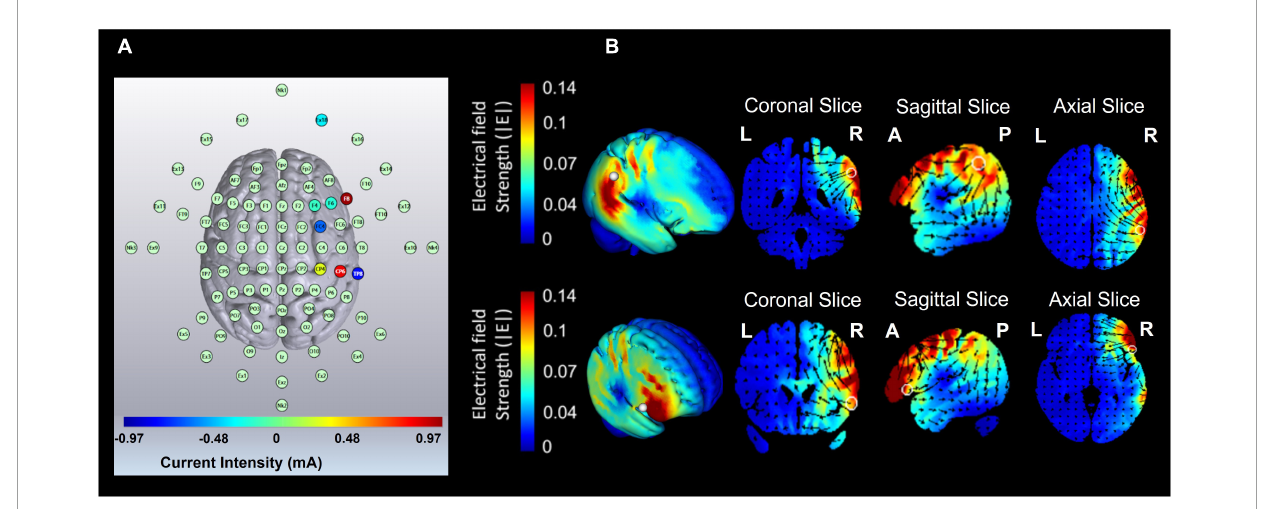
FIGURE3 Current flow modeling during 1 mA high-definition transcranial direct current stimulation (HD-tDCS) using the HD-Target software (Soterix Medical, New York, NY). (A) High-definition transcranial direct current stimulation (HD-tDCS) montage for maximal focal stimulation of the right inferior parietal lobe (IPL) and the right inferior frontal gyrus (IFG). (B) Current flow modeling during 1 mA high-definition transcranial direct current stimulation (HD-tDCS) using HD-Target software (Soterix Medical, New York, NY). Current-flow models of the right IPL and the right IFG are